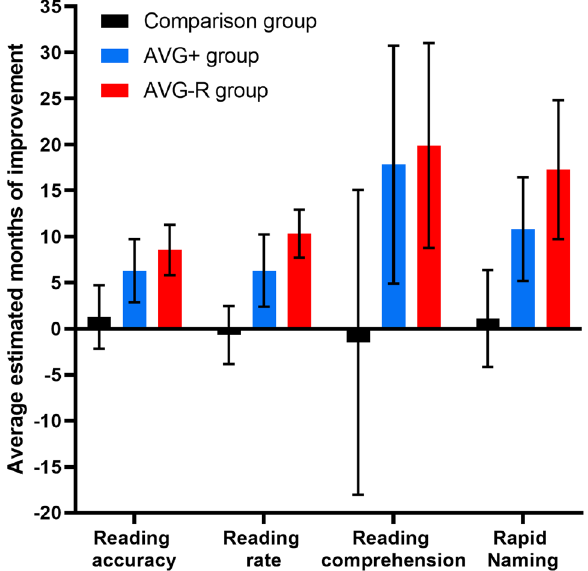
Figure 2. Dyslexic children’s average estimated months of improvement in performances on reading and rapid naming following AVG+ training, AVG-R training or treatment-as-usual (comparison group). Improvement estimates are based on the change between T1 and T2 in normative age equivalent estimates provided by the clinical test manuals (i.e., YARC, CTOPP-2). Means and 95% confidence intervals are displayed.